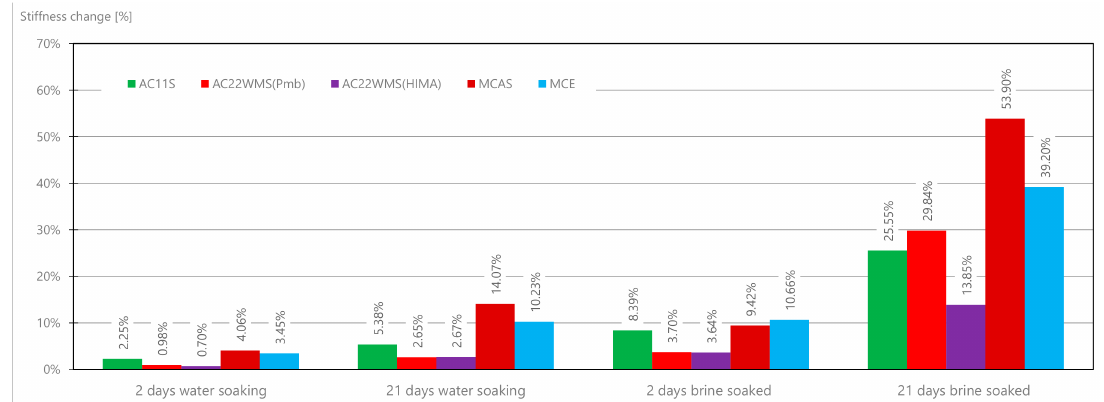
Figure 19. Stiffness modulus change results for various mixes.